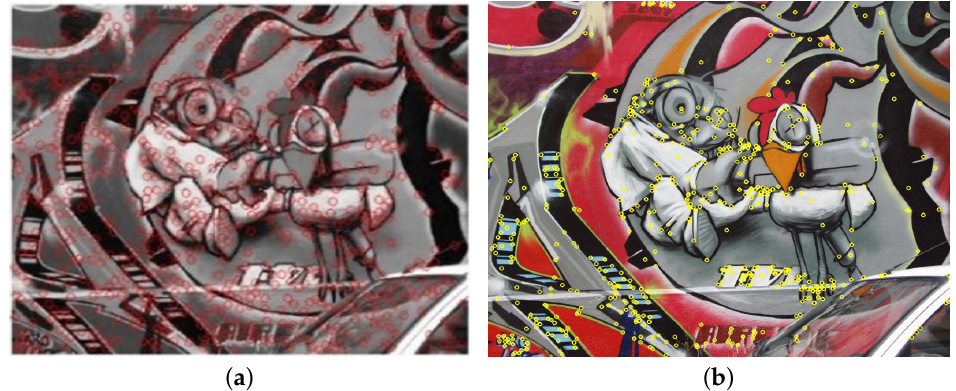
Figure 12. The extraction result of feature points of the reference image. ( a ) The extraction result of the adaptive RKEM algorithm; ( b ) the extraction result of the algorithm in this paper.